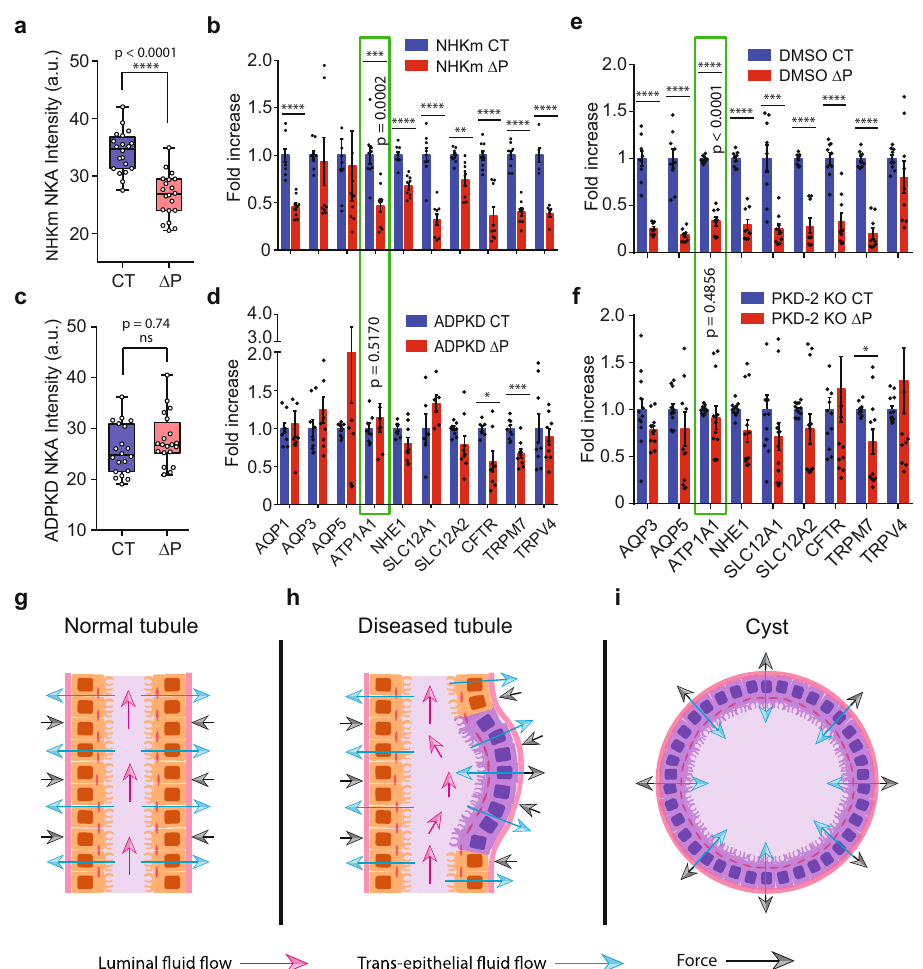
Fig. 6 Diseased cells have defects in sensing hydrostatic pressure as compared to normal cells. a Total intensity of NKA in NHKc cells at control, CT and pressure, Δ P . ( n = 20, N = 3, cells, independent biological repeats). See Fig. 1 caption for explanation of box-plot. b Relative expression changes of genes in NHKm cells for CT ( Δ P = 0) and Δ P ( Δ P = 200 Pa). ( n = 9, N = 3). c Total intensity of NKA in human ADPKD cystic cells for CT and Δ P = (ns not signi fi cant, p = 0.74, two-tailed Mann – Whitney t -test), ( n = 20, N = 3). d Comparison of the same genes ADPKD cystic cells for CT ( Δ P = 0) and Δ P = − 200 Pa ( n = 9, N = 3). Green rectangle highlights ATP1A1 (encodes for NKA). For human NHKm cells, mRNA levels of ATP1A1 decreased signi fi cantly (*** p = 0.0002) under Δ P for 10 h but remained unchanged for cystic cells ( p = 0.5170). For NHKm cells, ** p SLC12A2 = 0.0012, **** p < 0.0001. For ADPKD cells, * p CFTR = 0.0499, *** p TRPM7 = 0.0008. e Relative gene expression in inducible mouse cells with DMSO vehicle for CT and Δ P ( n = 6, N = 2). f Relative expression changes of genes in Pkd2 KO mouse cells for CT and Δ P . ( n = 12, N = 4). For normal mouse cells, ATP1A1 mRNA levels increased signi fi cantly (**** p < 0.0001) under Δ P but not for Pkd2 KO cells ( p = 0.4856). For normal mouse cells, *** p SLC12A1 = 0.0003, **** p < 0.0001. For PKD2 KO cells, * p TRPM7 = 0.0165. Error bars indicate SEM. (Unpaired, two-tailed, Mann – Whitney t -test). g A schematic of epithelial cells in MFKP device. Blue arrows indicate absorptive fl uid fl ux. Black arrows indicate the restoring force due to pressure gradient ( Δ P ). h PKD2 KO in a mouse cell line decreased the absorptive fl uid fl ux. Decreased pumping force due to diseased cells will cause a force imbalance and may destabilize the epithelium. i In human ADPKD cystic cells, fl uid pumping reverses in direction causing elevated pressure on the apical side. Hydraulic pressure gradient may aid in expansion of mature